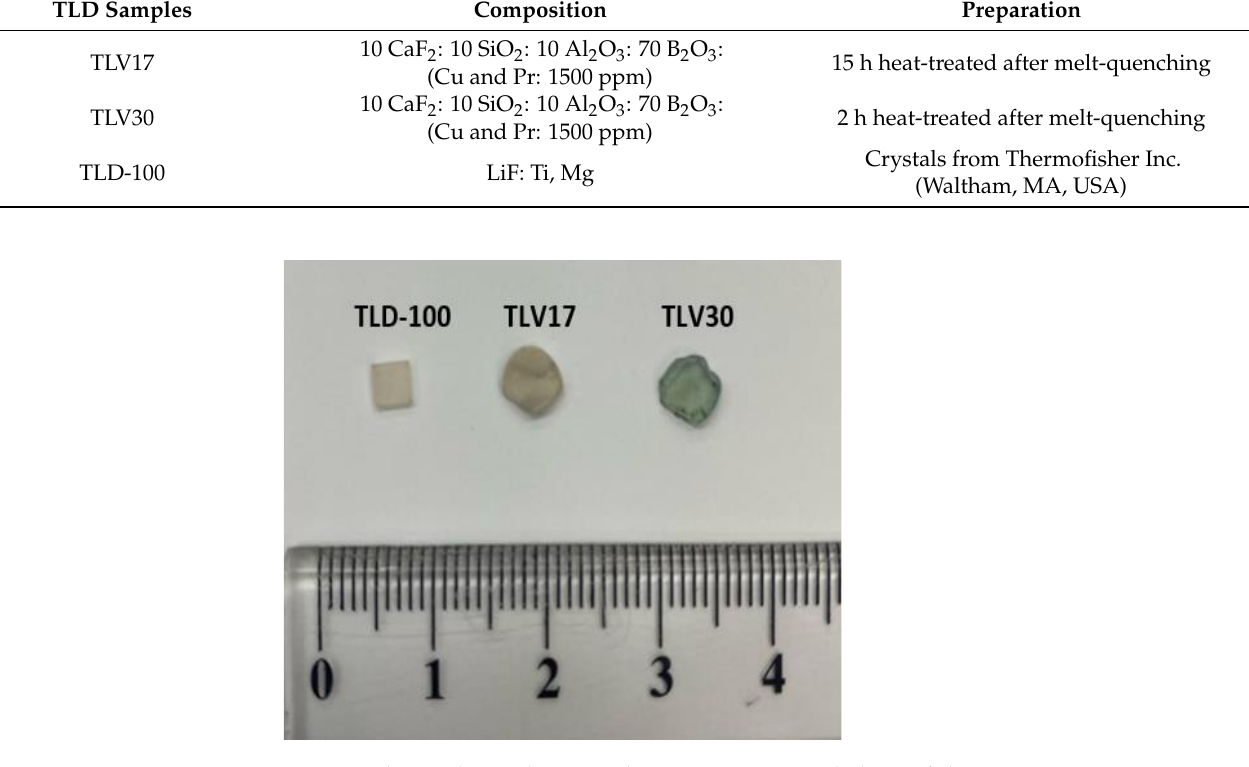
Figure 1. The synthesized TL samples TLV17, TLV30 and Thermofisher TLD-100.